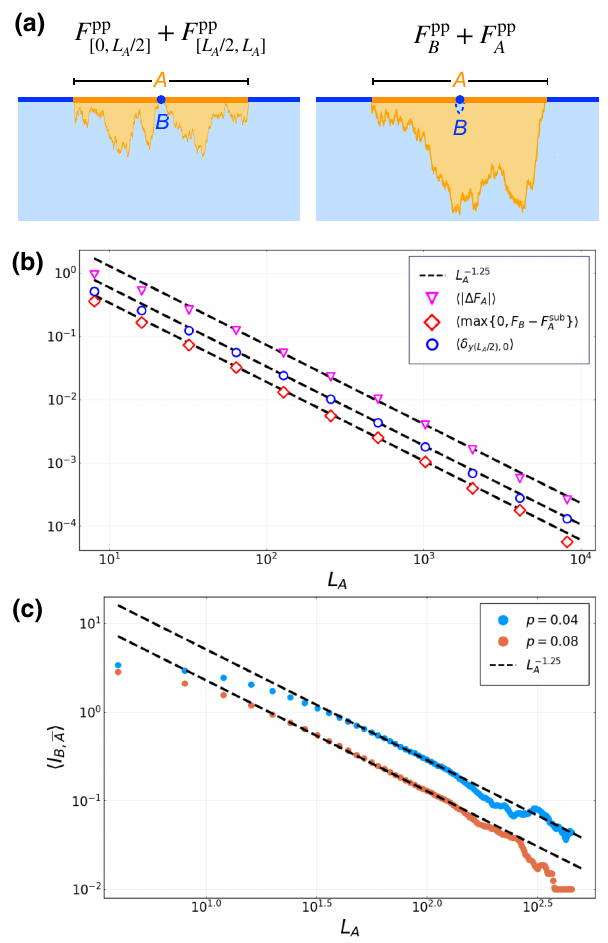
FIG. 6. (a) Two configurations of DPRE that contributes to S A − B in Eq. (22), where A − B consists of two disjoint segments [0, L A / 2] and [ L A / 2, L A ], highlighted in blue. The calculation fol- lows from a general prescription in Refs. [5,6], where the directed polymers act as “domain walls” that separate boundary regions of different colors. (b) The mean values of several observables for the DPRE at zero temperature, which can all be related to (cid:7) for the geometry in (a). They show the same powerlaw (cid:6) I B , A , where (cid:7) ≈ 1.25. (c) The mean mutual information decay L − (cid:7) A (cid:7) computed from the random Clifford circuit in the volume- (cid:6) I B , A law phase, for the geometry in (a). Here we take L B = 2, and L A ≤